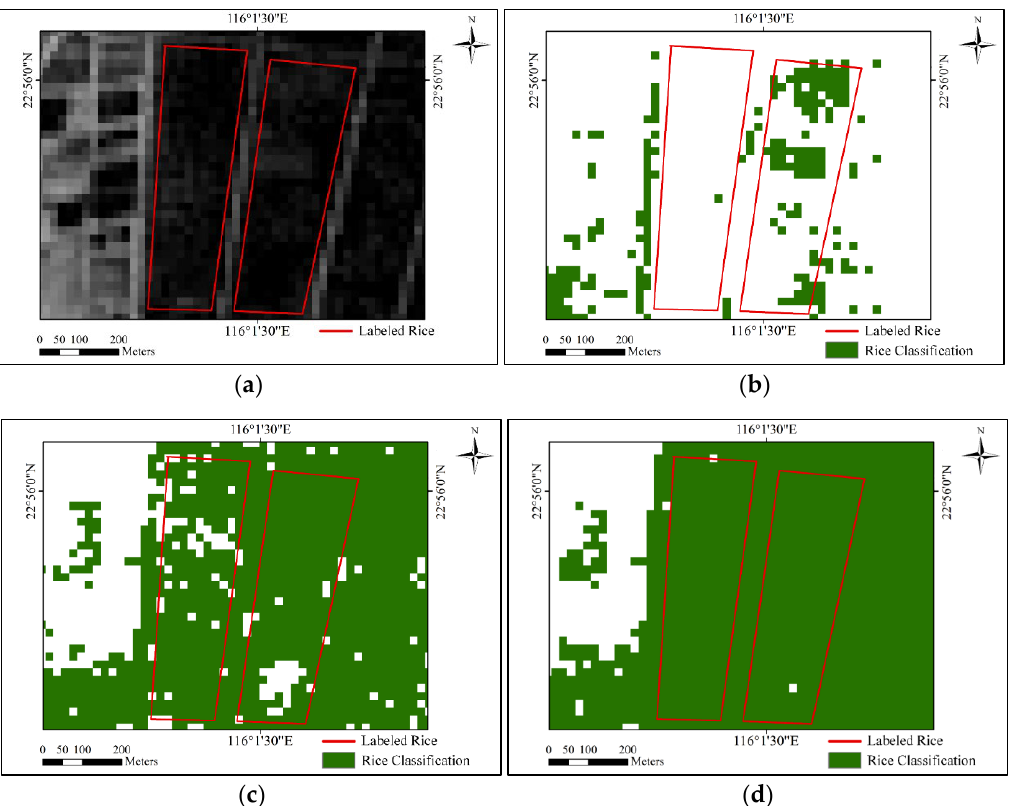
Figure 9. Comparison of classification results of different methods. ( a ) Label; ( b ) RF; ( c ) BiLSTM; ( d ) DB-BiLSTM.